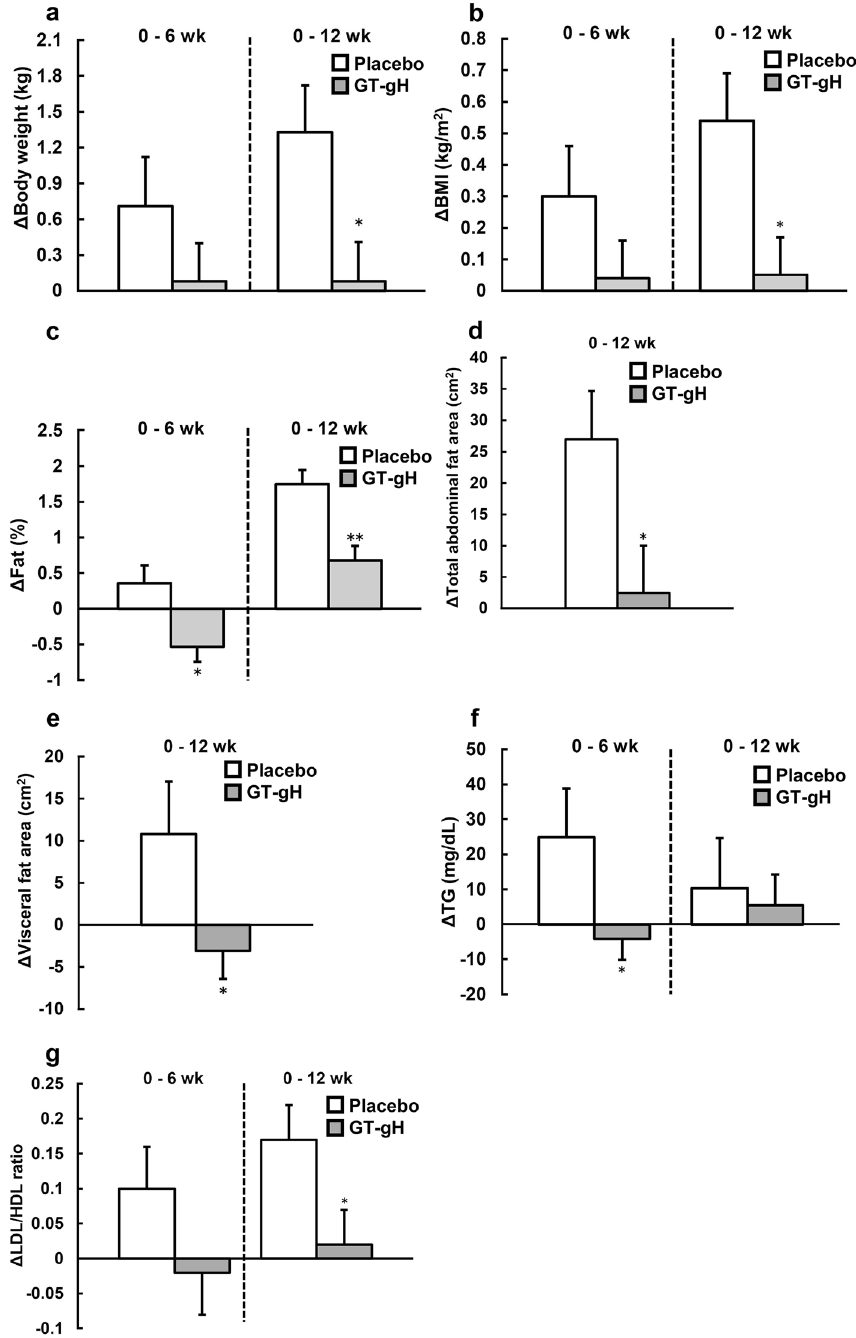
Figure 3. Subgroup analysis of the change amount of obesity-related parameters in subjects below 50 years old in the placebo (n = 10) or GT-gH (n = 13) groups. ( a ) Body weight, ( b ) BMI, and ( c ) fat were measured by a dual-frequency body composition analyzer. ( d ) Total abdominal fat area and ( e ) visceral fat area were measured by PET-CT and Fat Checker. ( f ) TG was measured by free-glycerol elimination method, ( g ) LDL/HDL ratio was measured by selective solubilization method and selective suppression method. ( a – g ) were analyzed by independent two-sample t-test. * p < 0.05, ** p < 0.01 (vs. placebo). Gray bars represent GT-gH, and open bars represent placebo. Data are shown as means ± SE. GT-gH green tea with α-glucosyl hesperidin; LDL/HDL ratio ratio of low-density lipoprotein to high-density lipoprotein; TG